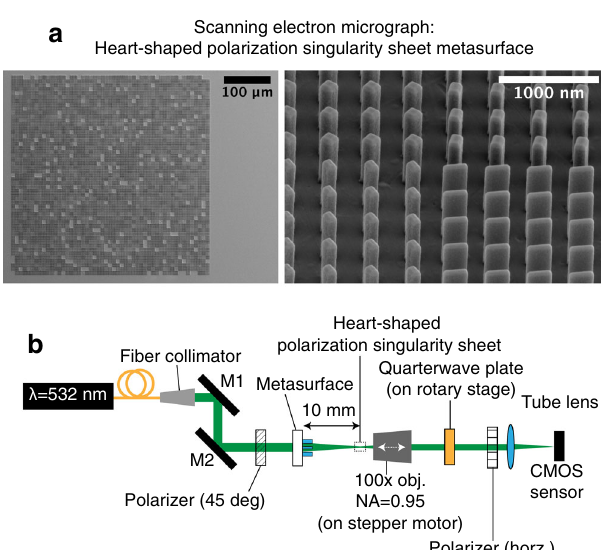
Fig. 6 Fabrication and characterization of the heart-shaped polarization singularity metasurface. a Left, SEM image of the fabricated metasurface, which comprises 51 × 51 superpixels with a pitch of 8.4 μ m. Each superpixel comprises 20 × 20 nano fi ns with a pitch of 0.42 μ m. a Right, high- magni fi cation SEM image at the interface of four pixels showing the individual nano fi ns. b Experimental setup for optical characterization of the 2D polarization singularity metasurface. The incident laser light is polarized at 45°. The transmitted light is magni fi ed through a ×100 objective (numerical aperture (NA) = 0.95) before passing through a quarterwave plate and a horizontal analyzer. An image of the optical fi eld is captured by a complementary metal oxide semiconductor (CMOS) camera sensor for every 5° of rotation of the quarterwave plate up to a total rotation angle of 180° from the horizontal. These images are used to reconstruct the polarization state of the optical fi eld at a pixel-by-pixel